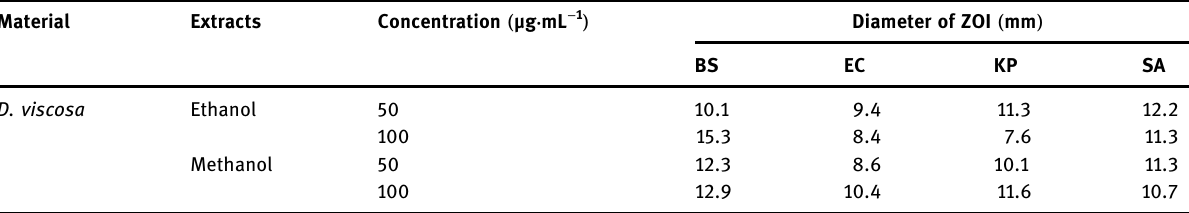
Table 1: Antimicrobial activity of ethanolic and methanolic extracts of D. viscosa Material Extracts